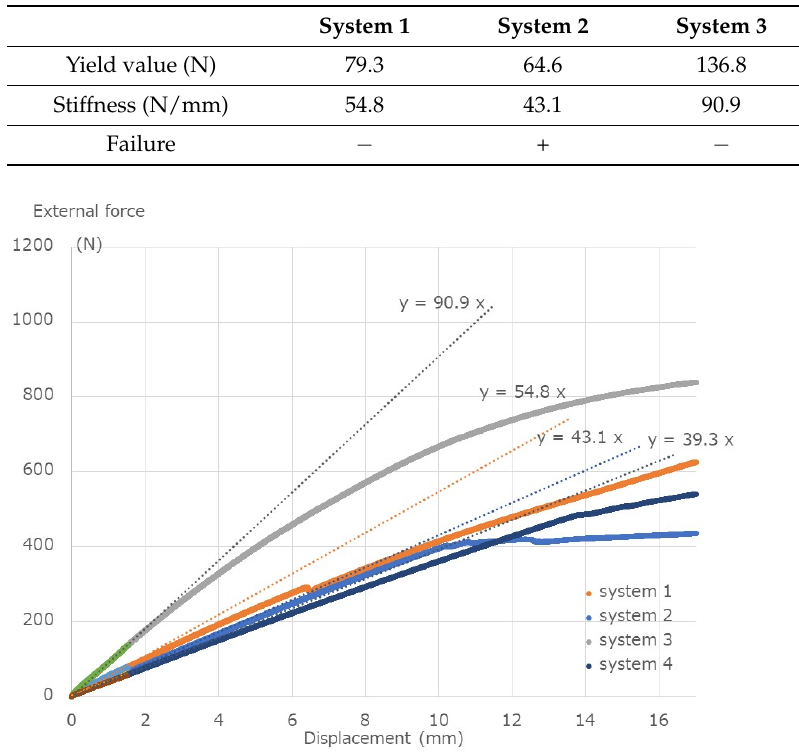
Figure 5. Break test results. The external force–displacement curve shows that the initial slopes are Y = 54.8 × X for System 1, Y = 43.1 × X for System 2, Y = 90.9 × X for System 3, and Y = 39.3 × X for System 4.